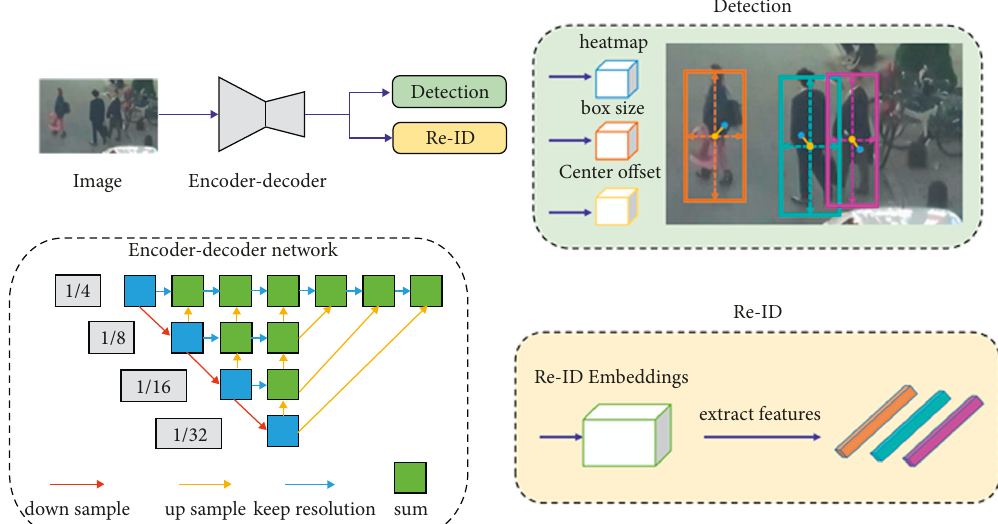
Figure 8: Research